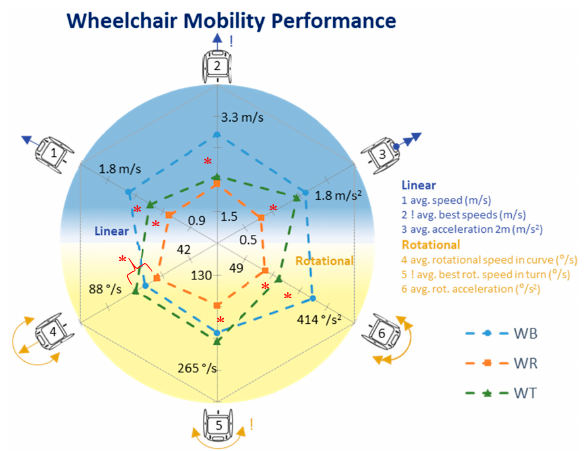
Figure 2. WMP for all sports. Significant (p < 0.05) differences are marked with a *. See Table A1 for the values (Appendix A).